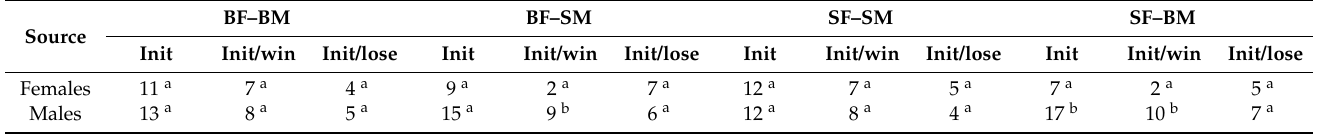
Table 3. Total number of crabs initiating and winning as well as initiating but losing in